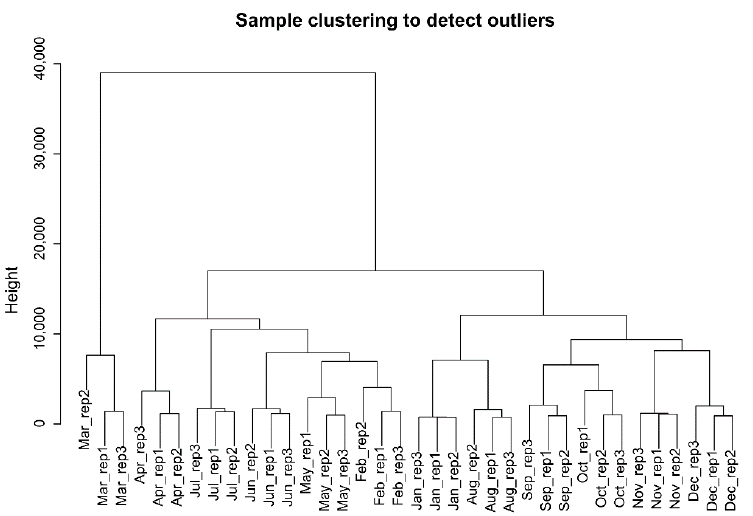
Figure 1. Hierarchical clustering information of